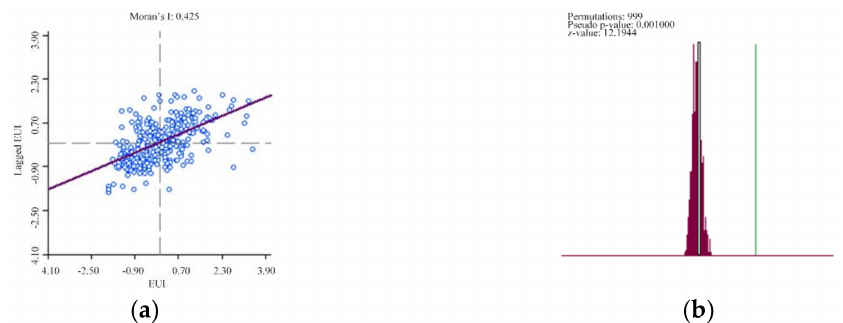
Figure 10. ( a ) LISA scatter plot frame of heating EUI; ( b ) the randomization test